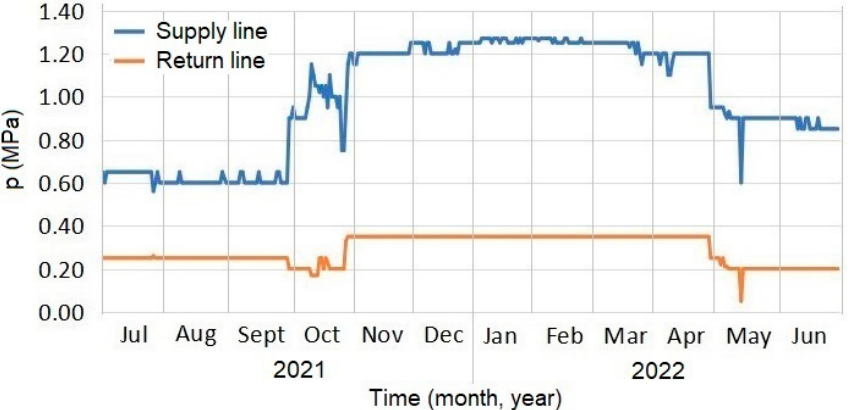
Figure 17. Water pressure variation in the transmission network.